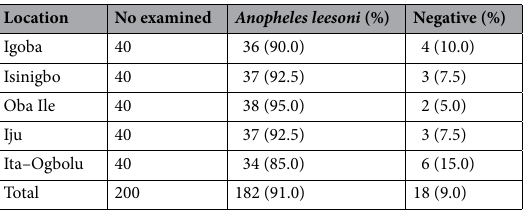
Table 3. Molecular identification of Anopheles funestus group in the study area. χ 2 = 557.72; df = 4; P = 0.01.